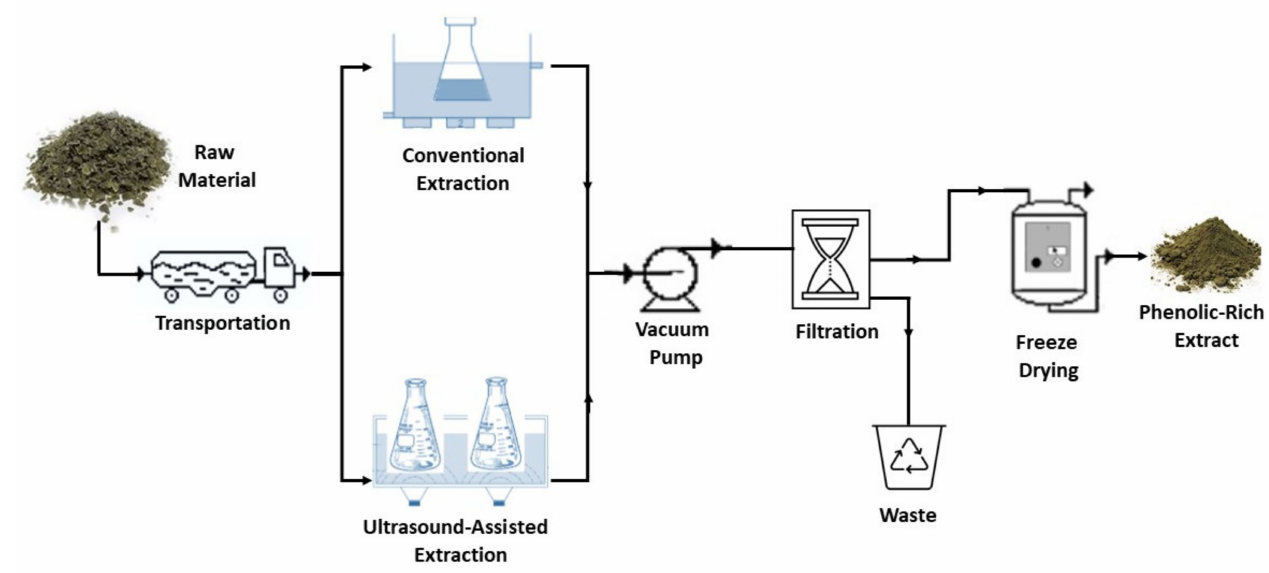
Figure 1. Schematic representation of the extraction process for the recovery of phenolic-rich extract from